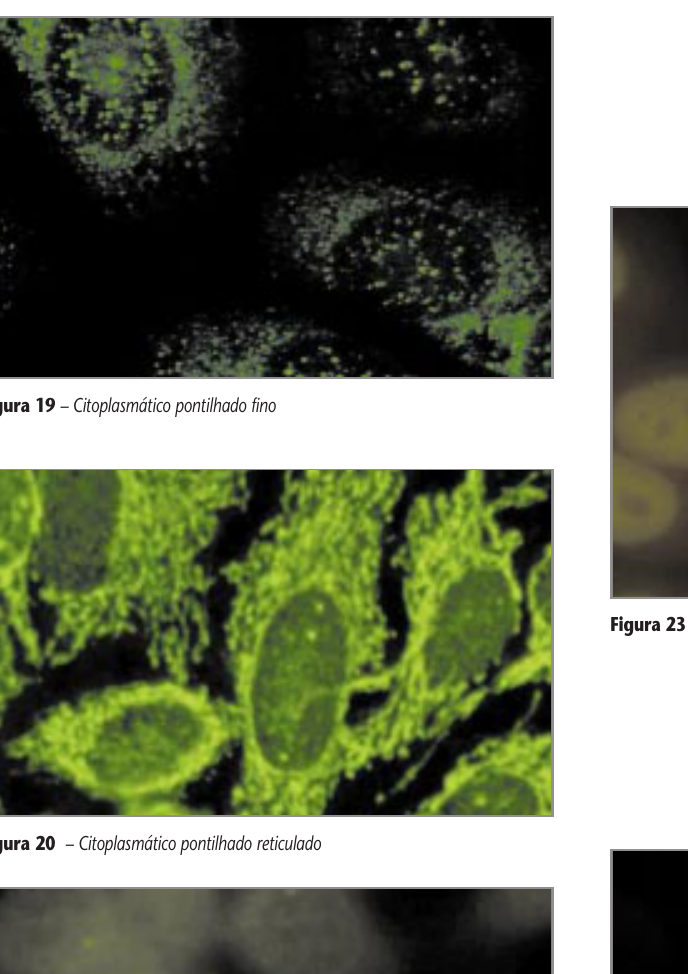
Figura 22 – Aparelho mitótico: ponte intercelular